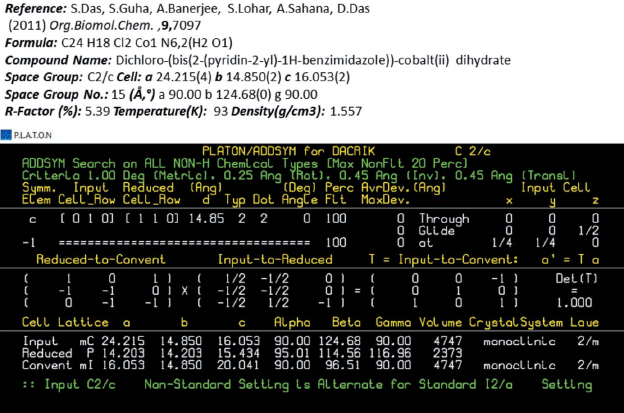
Figure 4 A view of the ADDSYM ( PLATON ; Spek, 2020) transformation of the cell dimensions of the isostructural compound dichloridobis[2-(pyridin-2- yl)-1 H -benzimidazole]cobalt(II) monohydrate (CSD refcode DACRIK; Das et al. , 2011).